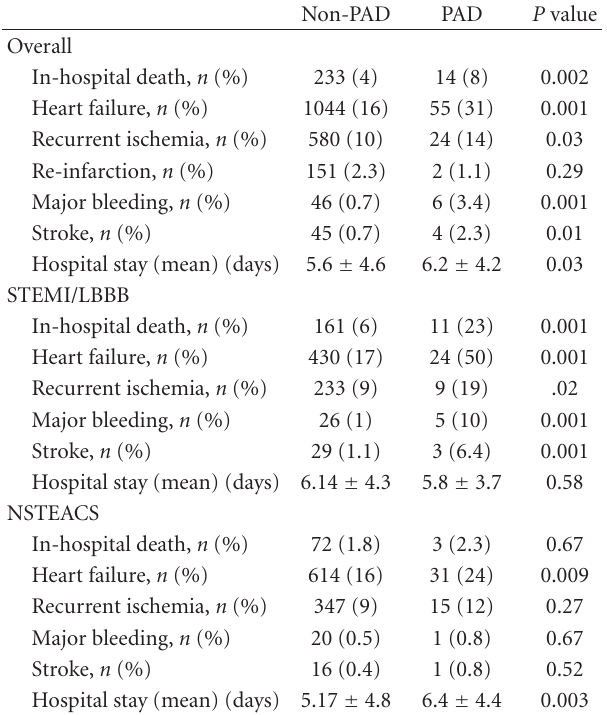
Table 3: Clinical outcomes in patients with acute coronary syndromes.